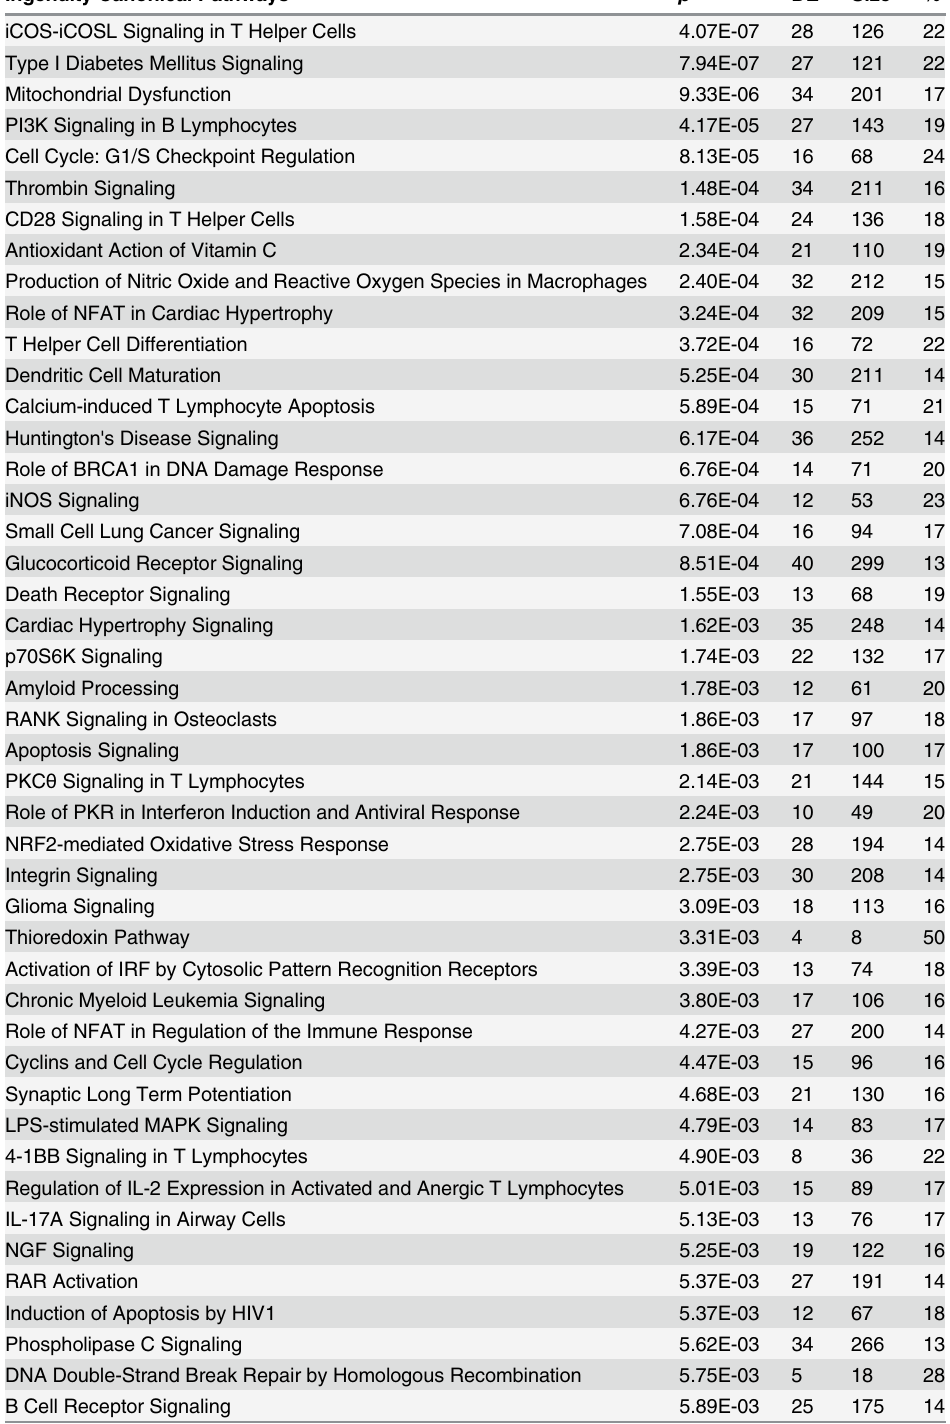
Table 4. Top 50 canonical pathways for union of RIP-Seq and RNA-Seq analyses sorted by p-value. Size indicates the number of molecules that comprise a pathway and DE indicates the number of significant genes identified by either RIP-Seq or RNA-Seq, where % represents DE/size. p is based on Fisher ’ s Exact Test and indicates pathways that are enriched for genes from RIP-Seq or RNA-Seq. Ingenuity Canonical Pathways p DE Size % iCOS-iCOSL Signaling in T Helper